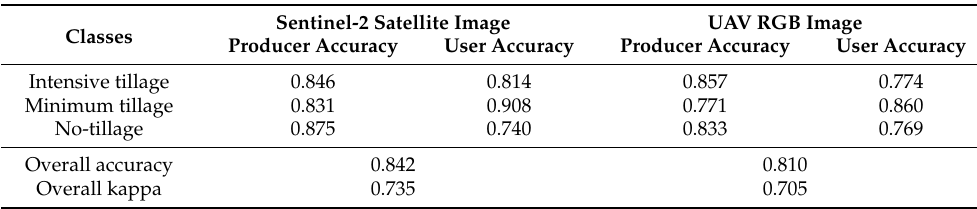
Table 6. Results of neural network classification for the digital images from UAV and spectral image from Sentinel-2